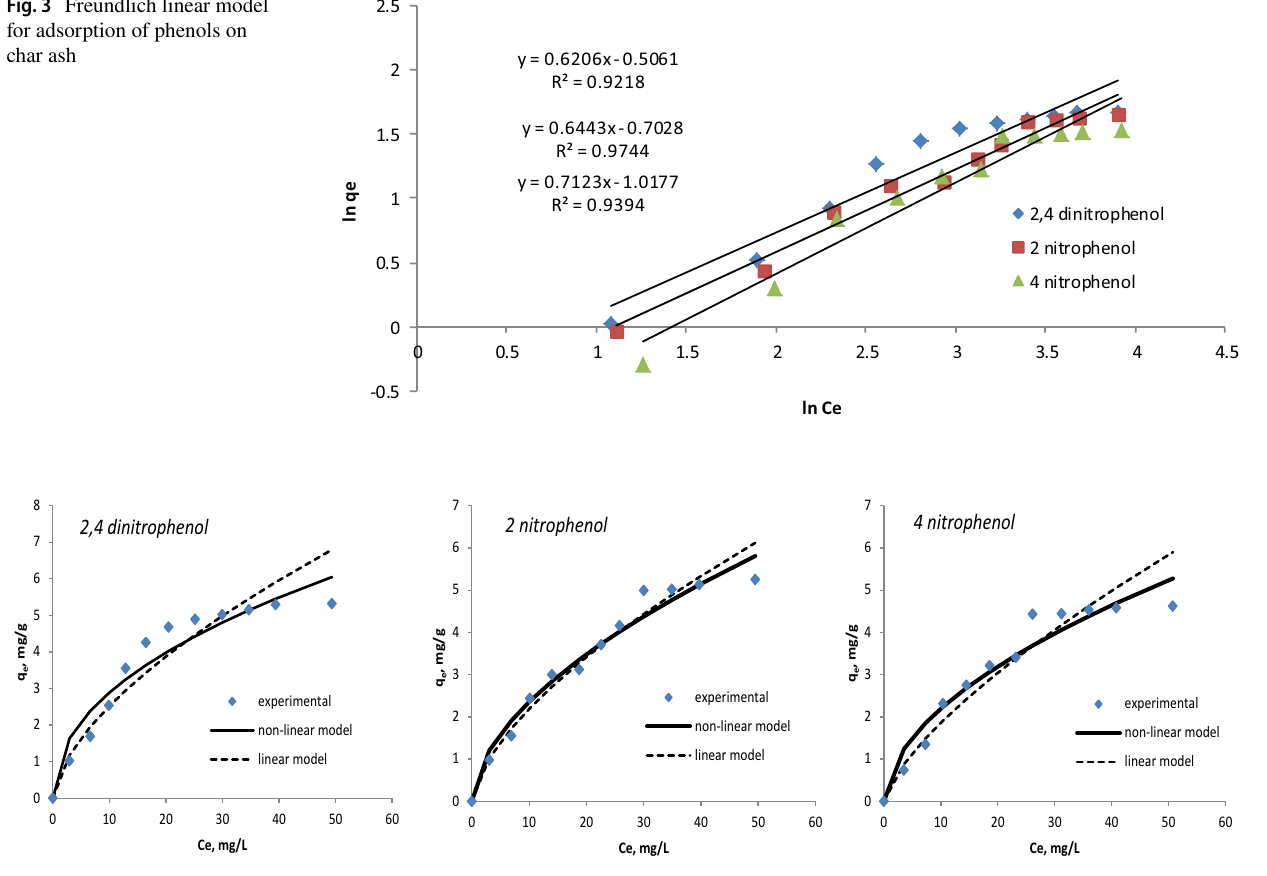
Fig. 4 Fitting of the experimental and model data to Freundlich isotherm for adsorption of phenols on char ash